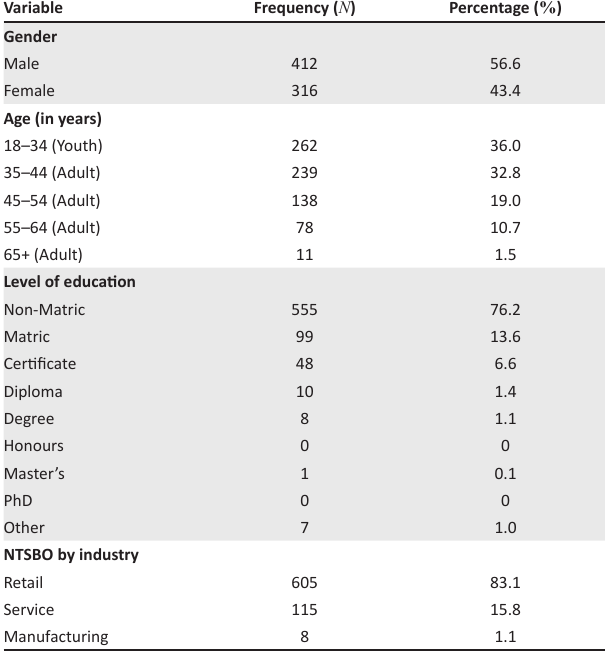
TABLE 3: Demographics of research